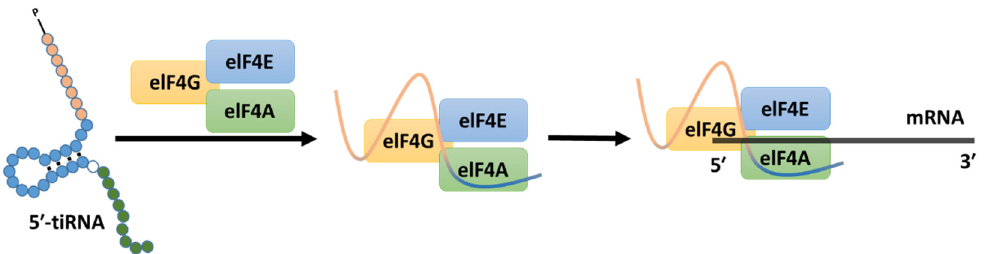
Figure 3. Cleavage of specific tRNAs in 5 ′ -tiRNAs can bind the G4 complex, displacing the elF4F factor and consecutively suppressing the translation by creating an RNA G-quadruplex (RG4s) on the mRNA cap that inhibits translation initiation complex.